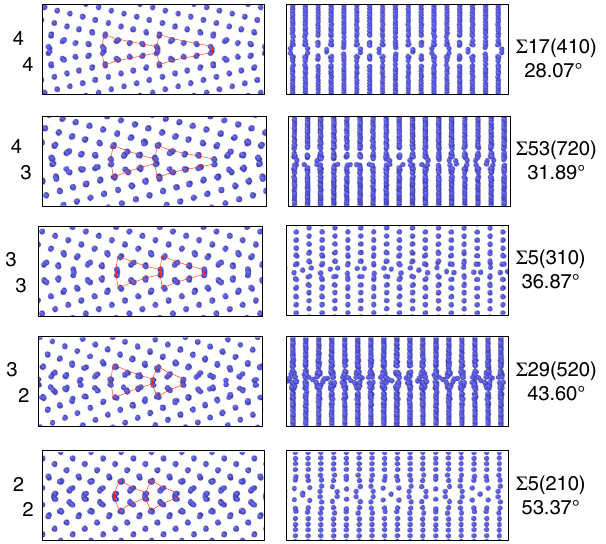
Fig. 4 Split Kite family. Split Kite phases of fi ve representative boundaries predicted by the evolutionary search and clustering analysis. For each misorientation GB structures are viewed parallel to the [001] tilt axis (left column) and normal to it (right column). The size of the structural units of this family changes with misorientation. Split Kites have higher atomic density compare to Kites, with extra atoms occupying interstitial positions between [001] planes